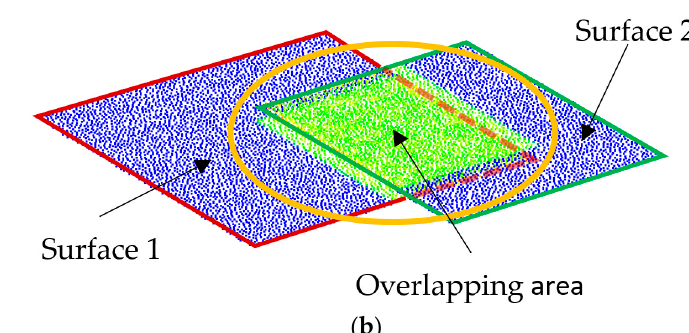
Figure 7. Functioning of the surface variation descriptor (image adapted from Pauly et al. [18]) ( a ); example of surface variation application in a generic case ( b ).